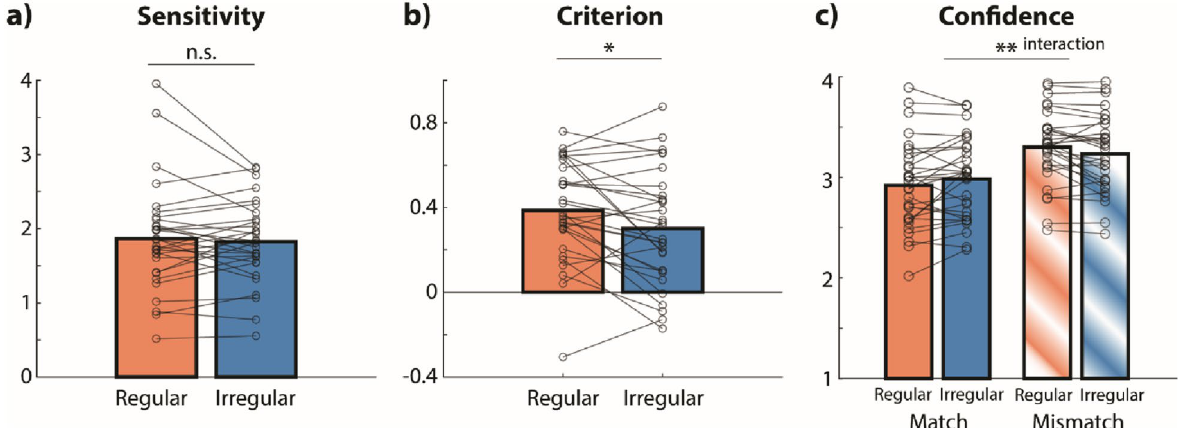
Figure 5. Sensitivity ( a ) and criterion ( b ) for temporally regular versus irregular distractors in Experiment 4. Bars shows means across all participants (N = 30). Lines show data from individual participants. ( c ) Interactive effect of temporal regularity and match, which refers to whether the memory probe matched with the encoding display, on confidence. n.s. not significant. *p < 0.05, **p <